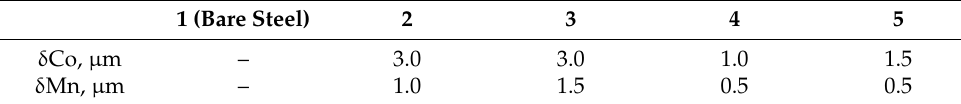
Table 3. The thickness of cobalt and manganese